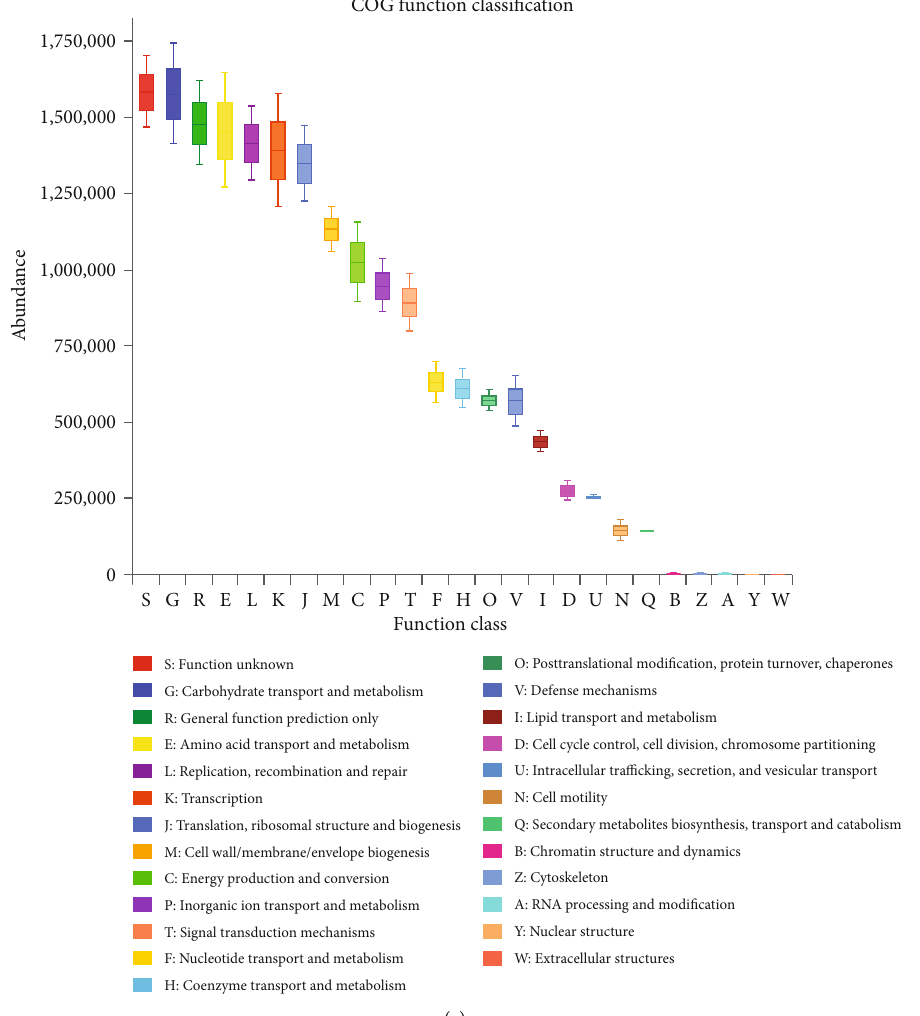
Figure 2: E ff ect of high-fat diet on ANP-associated injuries (TJPs and microbiota diversity) caused by retrograde sodium taurocholate infusion. Expression of caudin-1, occludin, and zo-1 as assessed by (a) western blot and (b) immunohistochemistry of the distal ileum. (c) Estimators of intestinal microbiota α -diversity in rats fed a high-fat or standard diet ( n = 8 ). (d) Principal component analysis of microbiota β -diversity ( n = 8 ). (e) Predicted microbial functional categories of 16S rRNA in fecal samples at 24 h after induction of ANP. ∗ p < 0 : 05 , ∗∗ p < 0 : 01 , ∗∗∗ p < 0 : 001 , Student ’ s t